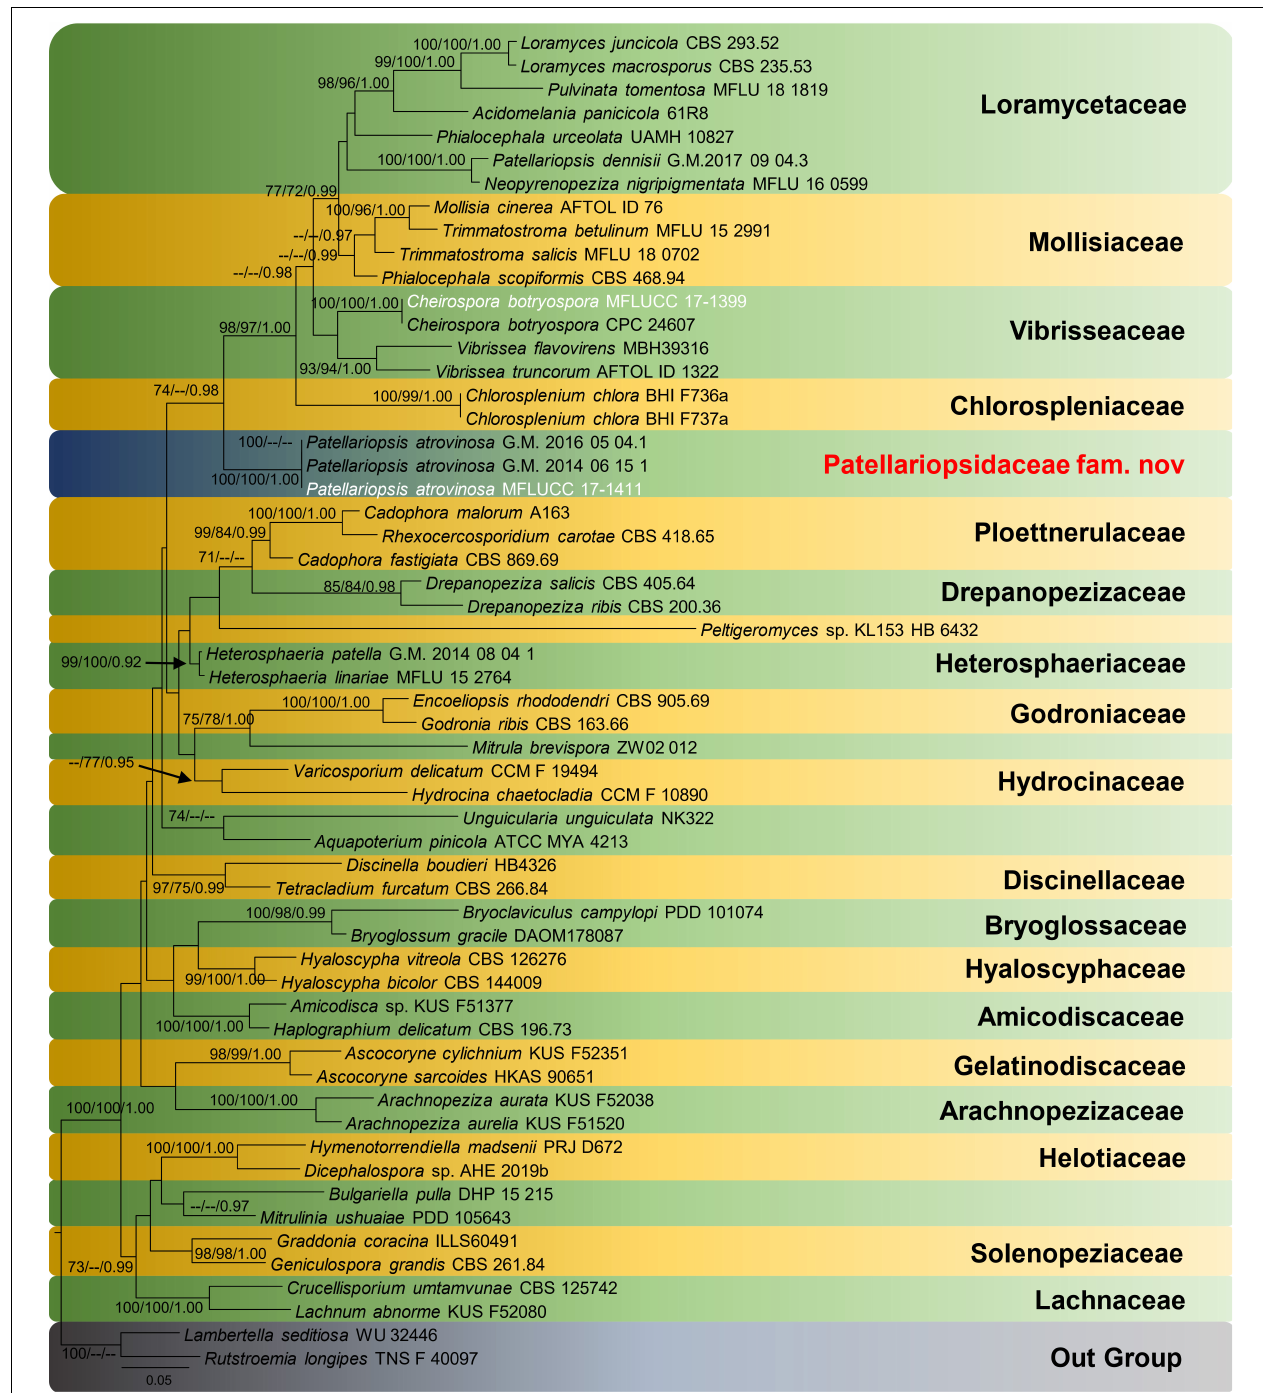
FIGURE 1 | RAxML tree based on a combined dataset of LSU and ITS partial sequence data. Bootstrap support values for maximum likelihood equal to or higher than 70%, maximum parsimony equal to or higher than 70%, and Bayesian posterior probabilities equal to or greater than 0.90 are displayed on the nodes, respectively. Newly generated sequences are indicated in white. The tree is rooted to Lambertella seditiosa and Rutstroemia longipes.